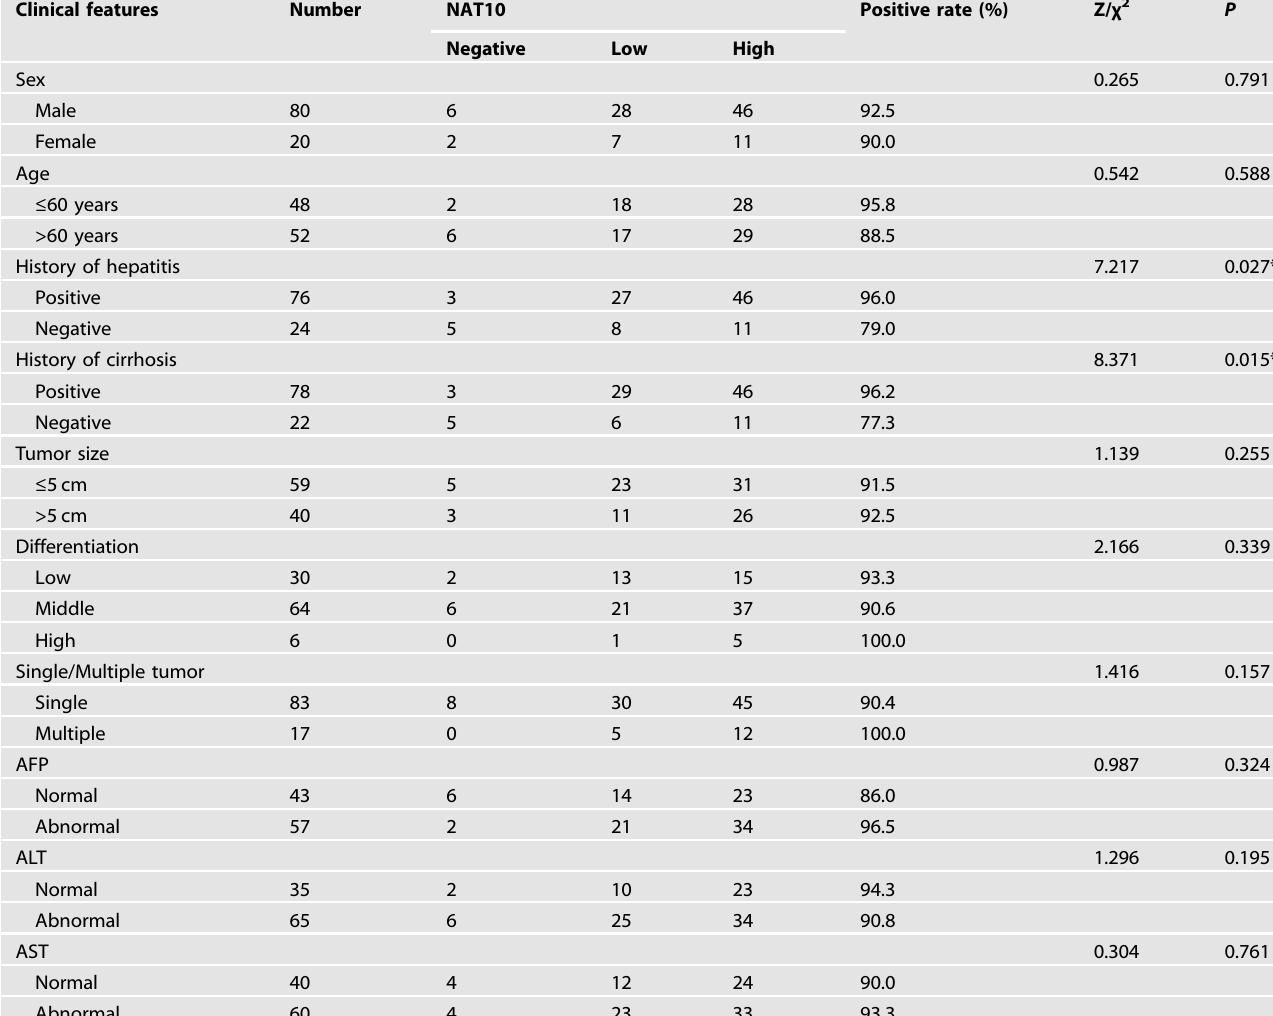
Table 1. Relationship between NAT10 expression level and clinical characteristics of HCC patients. Clinical